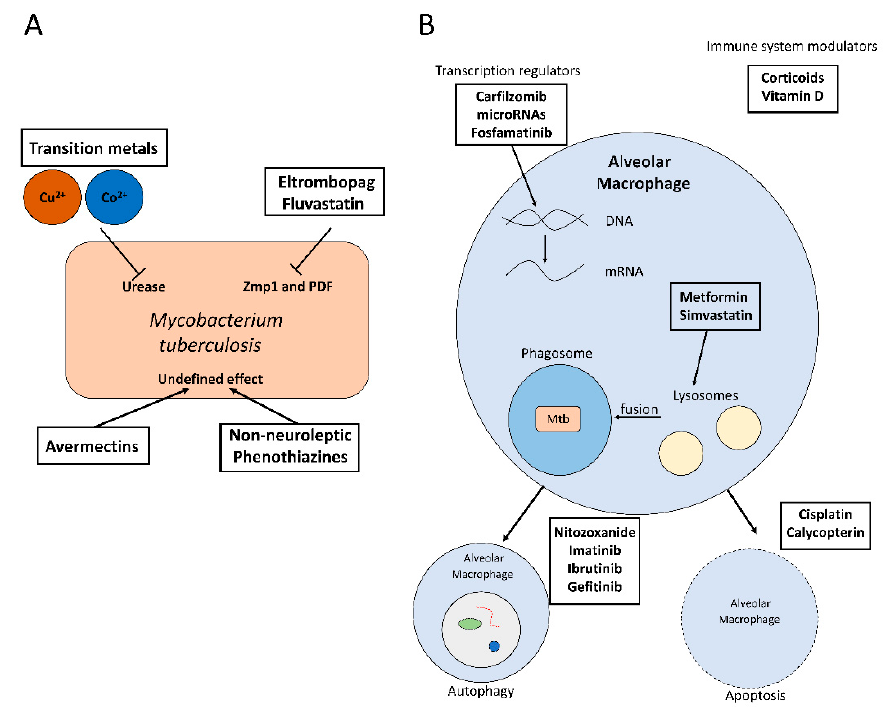
Figure 1. ( A ) Activity of some repurposed antimicrobials against M. tuberculosis . ( B ) Mechanism of action of some host-directed therapies to inhibit intracellular M. tuberculosis proliferation.